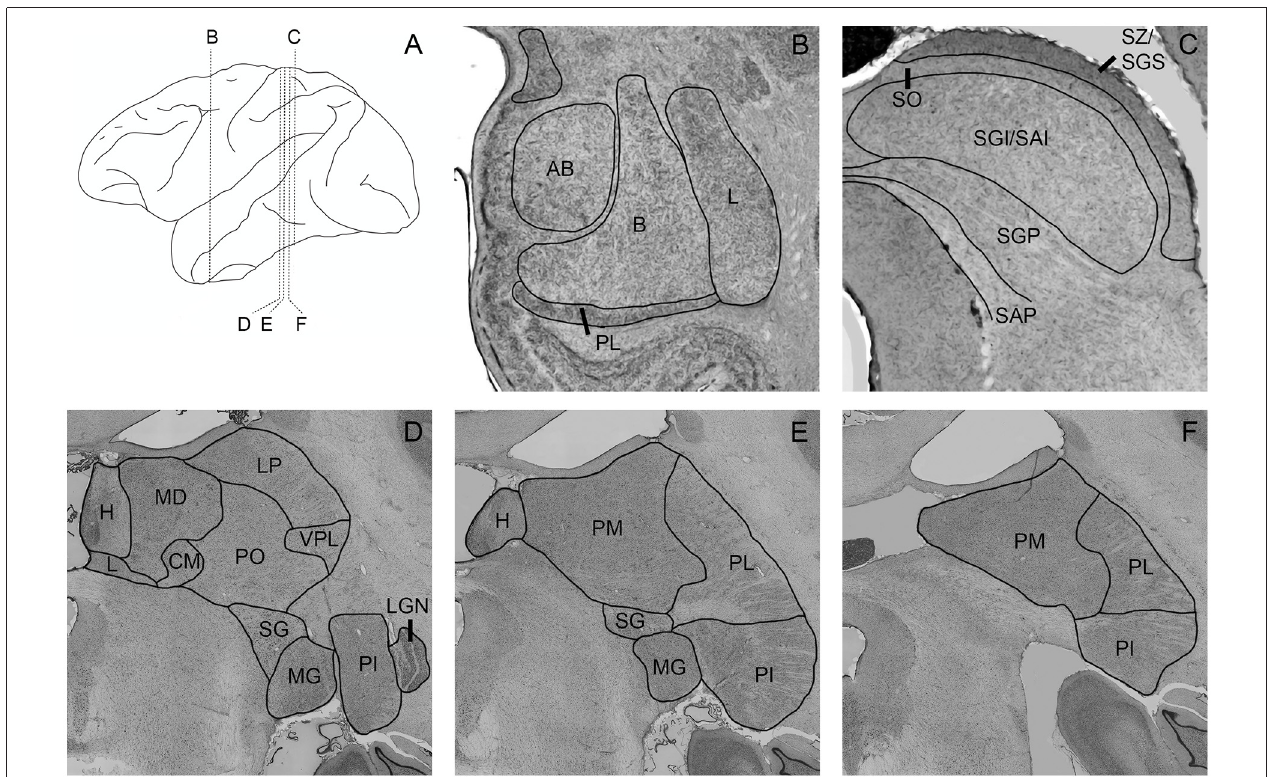
FIGURE 1 | Photomicrographs of nissl-stained sections through the amygdala, superior colliculus (SC), and pulvinar. Panel (A) shows the location of panels (B–F) within the brain. Amygdala nuclei (B) are outlined and labeled according to Amaral et al. (1992). AB, accessory basal; B, basal; L, lateral; M, medial; PL, paralaminar. SC nuclei (C) are outlined and labeled according to May (2006). SZ/SGS, stratum zonale/stratum griseum superficiale; SO, stratum opticum; SGI/SAI, stratum griseum intermedium/stratum album intermedium; SGP, stratum griseum profundum; SAP, stratum album profundum. Thalamic nuclei (D–F) are outlined and labeled according to the delineations of the Olszewski (1952). CM, centromedial nucleus; H, habenula; L, nucleus limitans; LGN, lateral geniculate nucleus; LP, lateral posterior nucleus; MD, mediodorsal nucleus; MG, medial geniculate nucleus; PI, inferior pulvinar; PL, lateral pulvinar; PM, medial pulvinar; PO, oral pulvinar; SG, suprageniculate nucleus; VPL, ventroposteriolateral